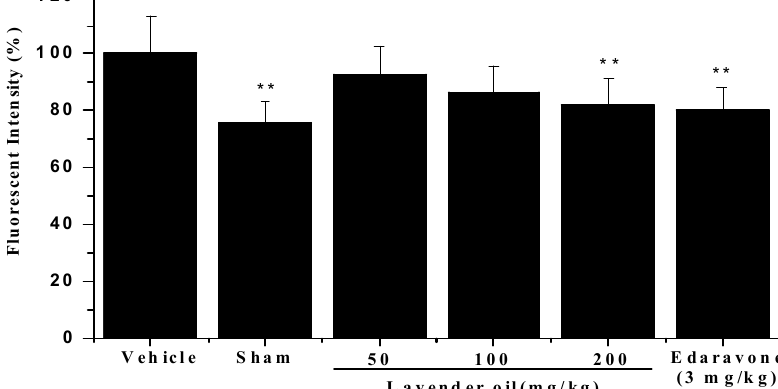
Figure 6. Reactive oxygen species (ROS) estimated after 22 h of